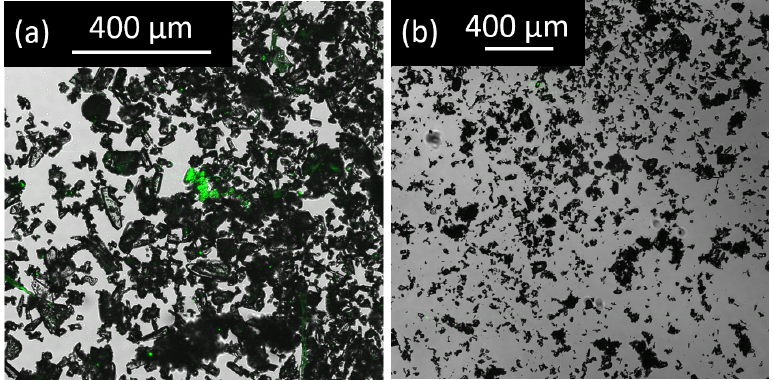
Figure 8. Overlay of SHG and optical microscopy images highlighting: ( a ) the presence of non-centrosymmetric zone in ArgFum crystals obtained by the standard protocol, ( b ) the absence of non-centrosymmetric zones in ArgFum crystals recrystallized gently from water. Particle size is between 50 and 100 μ m.